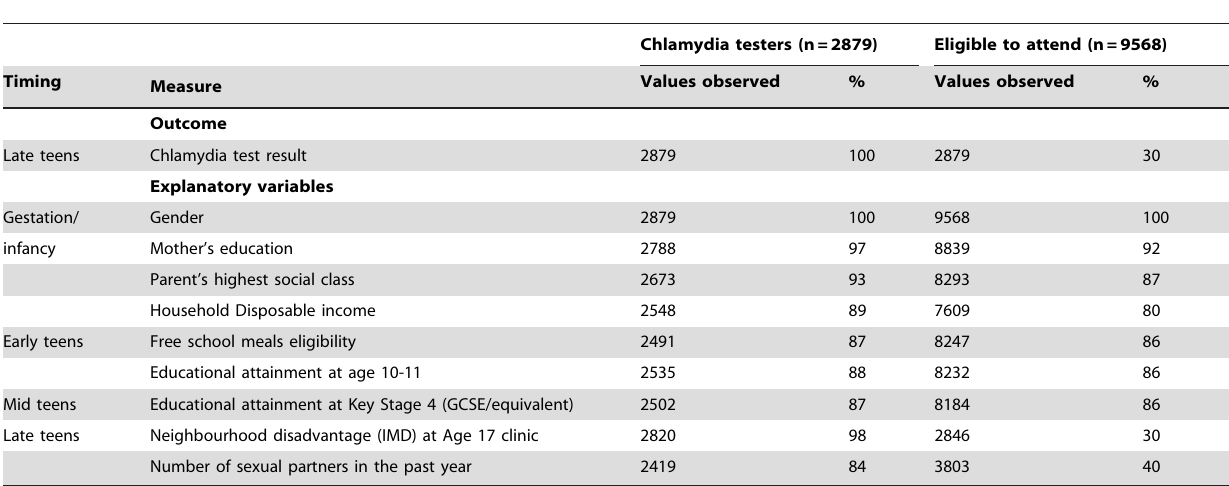
Table 1. Completeness of data among young people who tested for chlamydia at the research clinic and those who were invited to the clinic.